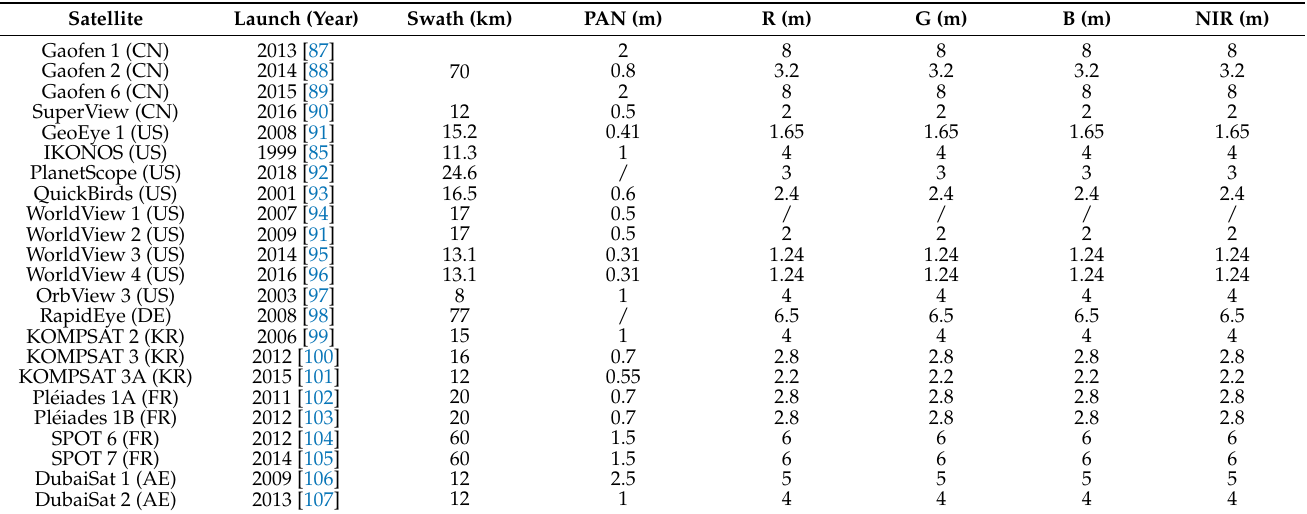
PAN: panchromatic. R: red. G: green. B: blue. NIR: near-infrared. WorldView 2 [91] and WorldView 3 [95] have four other multispectral bands (red edge, coastal, yellow and NIR), and RapidEye has another multispectral band (red edge)